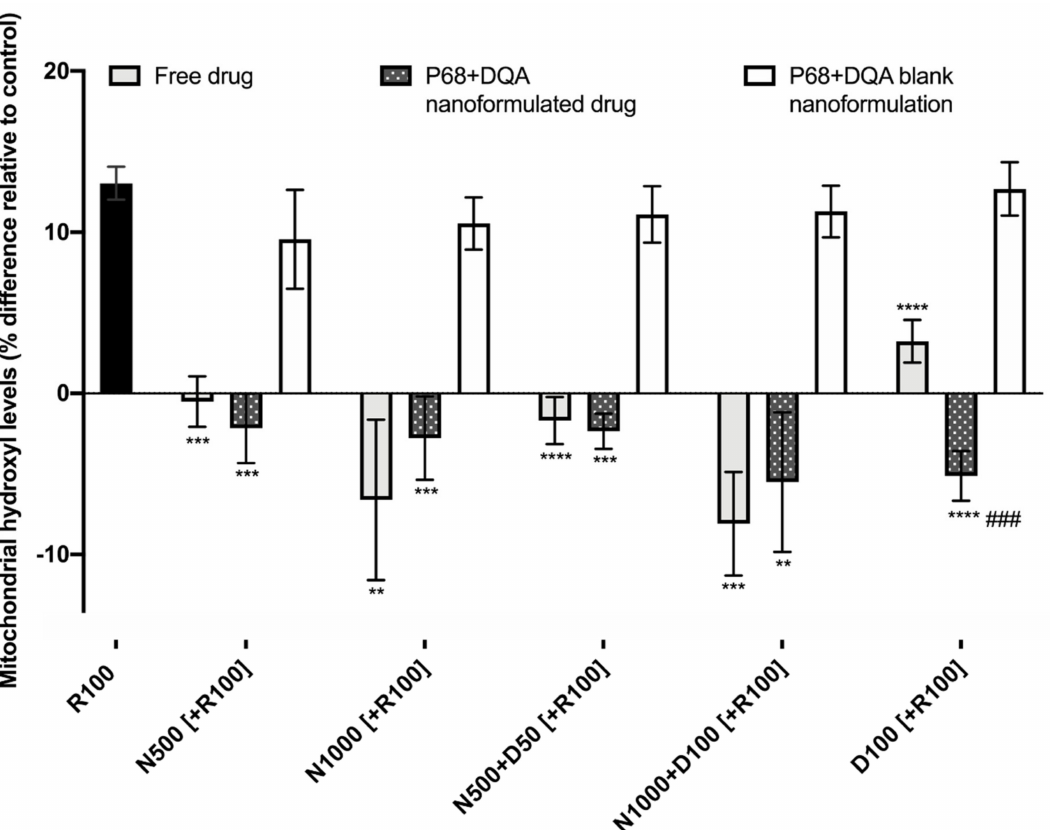
Figure 7. Mitochondrial hydroxyl assay results of 3 h pre-treatment with free, P68 + DQA or corresponding blank formulations of NAC (500 or 1000 µ M), combined NAC (500 or 1000 µ M) + DFO (50 or 100 µ M) or 100 µ M DFO alone (D100) followed by 24 h treatment with 100 µ M rotenone (R100) (mean ± S.D., n = 6). Mitochondrial hydroxyl levels are expressed as the percentage of hydroxyl identified in control cells (SH-SY5Y cells treated with MEM media only, for 24 h). *